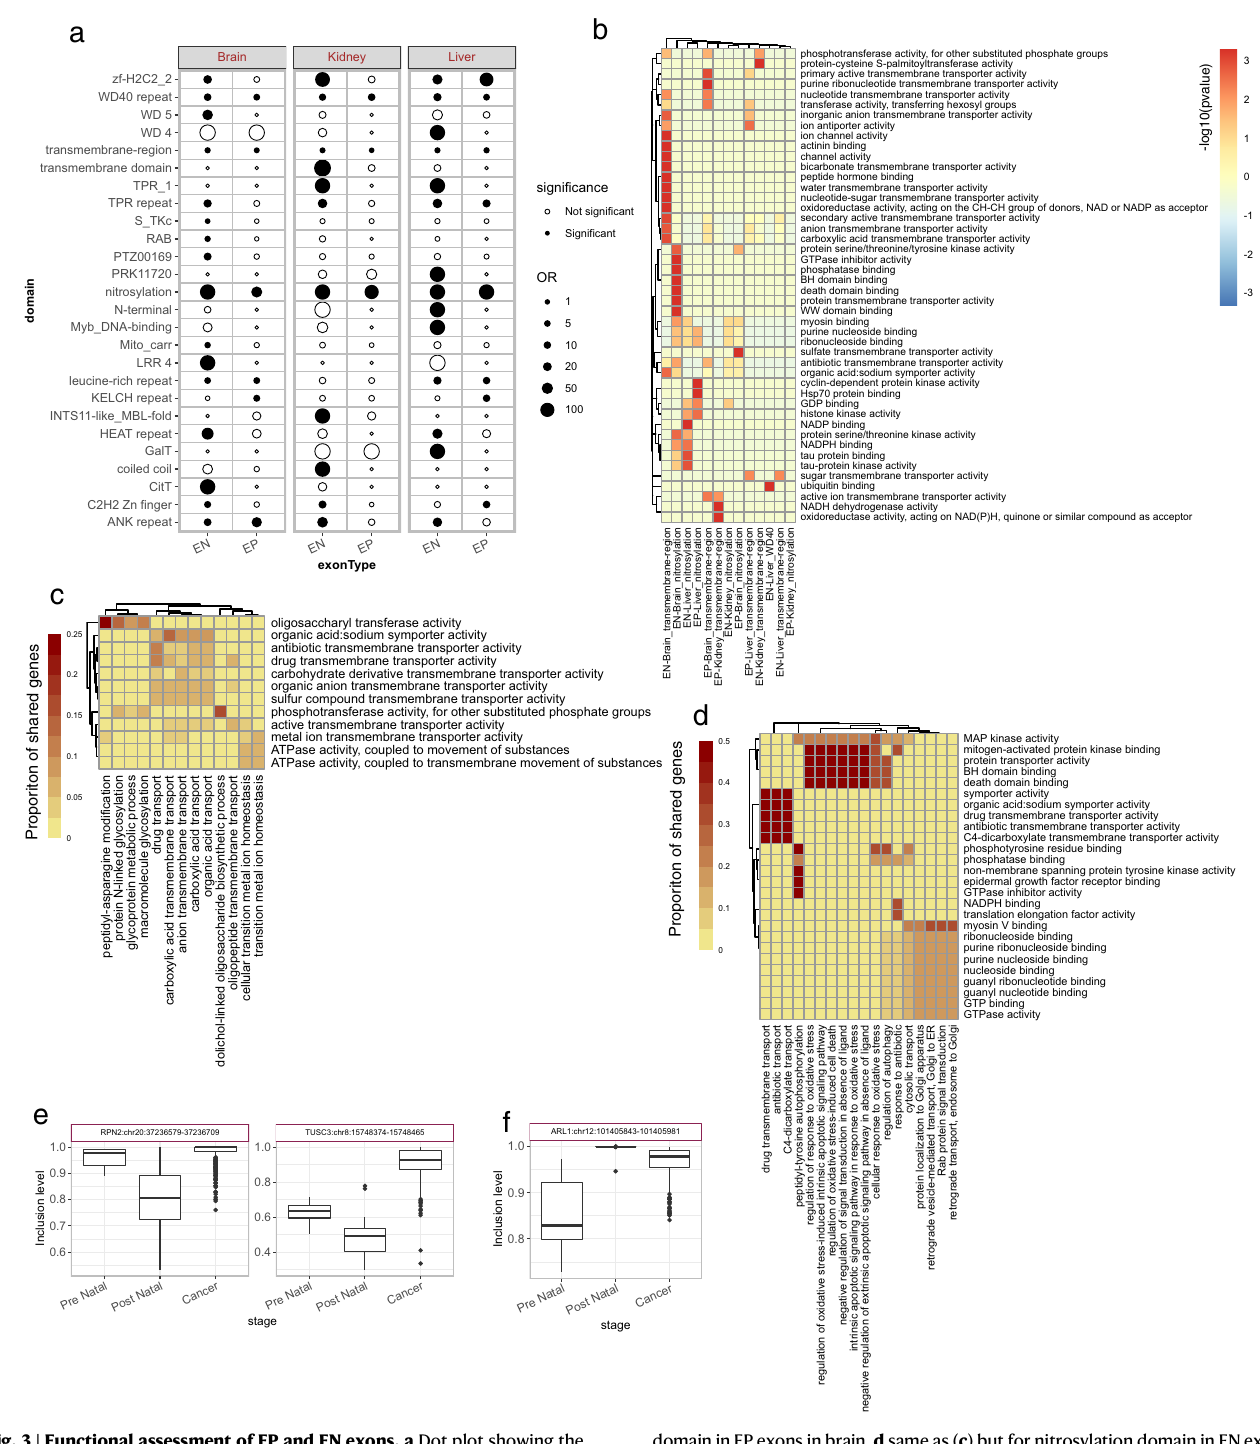
domaininEPexonsinbrain. d sameas( c )butfornitrosylationdomaininENexons in brain. e, f The inclusion of EP exons encoding TRD among the subunits of OST complex ( e ) and EN exons with ND among the GTPases potentially involved in the regulation of vesicle transport ( f ). In e , f , n =11 for pre-natal, n =21 for post-natal, and n =501forcancersamples.Inboxplots( e , f ),thehorizonallineinthemiddleis the median value and the lower and upper edges of the boxes correspond to the 25th and 75th percentiles. Extending vertically upwards/downwards of the boxes are the lines showing 1.5 times the interquartile range (i.e., distance between 25th and 75th percentile). Dots are the outliers. Source data for these fi gures are pro- vided as a Source Data fi